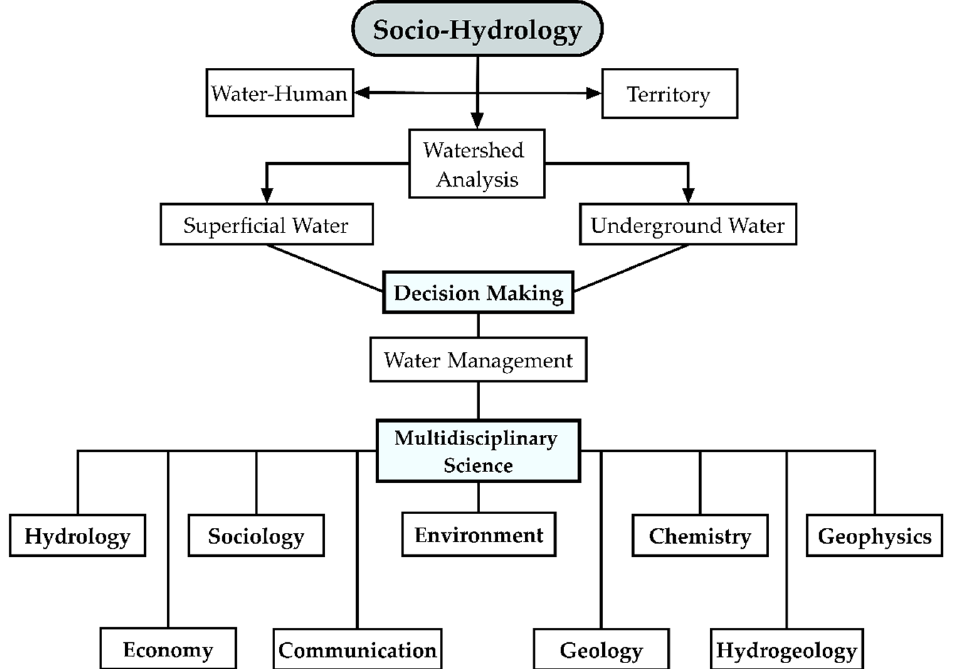
Figure 1. Conceptual scheme.